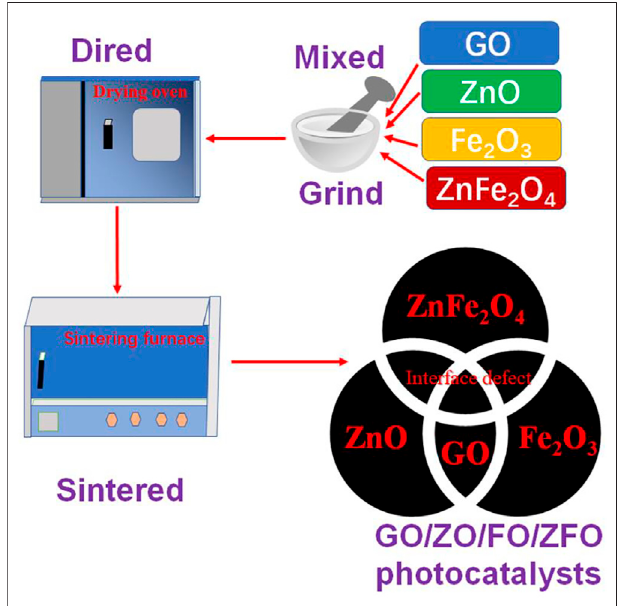
FIGURE 1 | Preparation of the fl owchart of